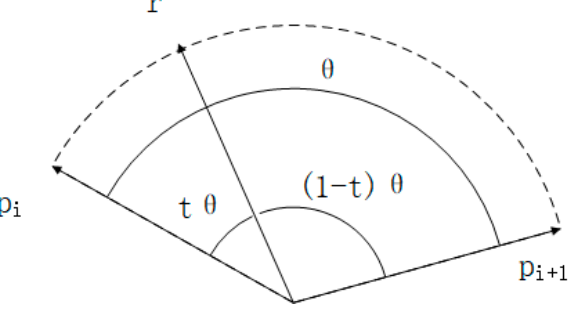
Figure 7. Spherical linear interpolation.